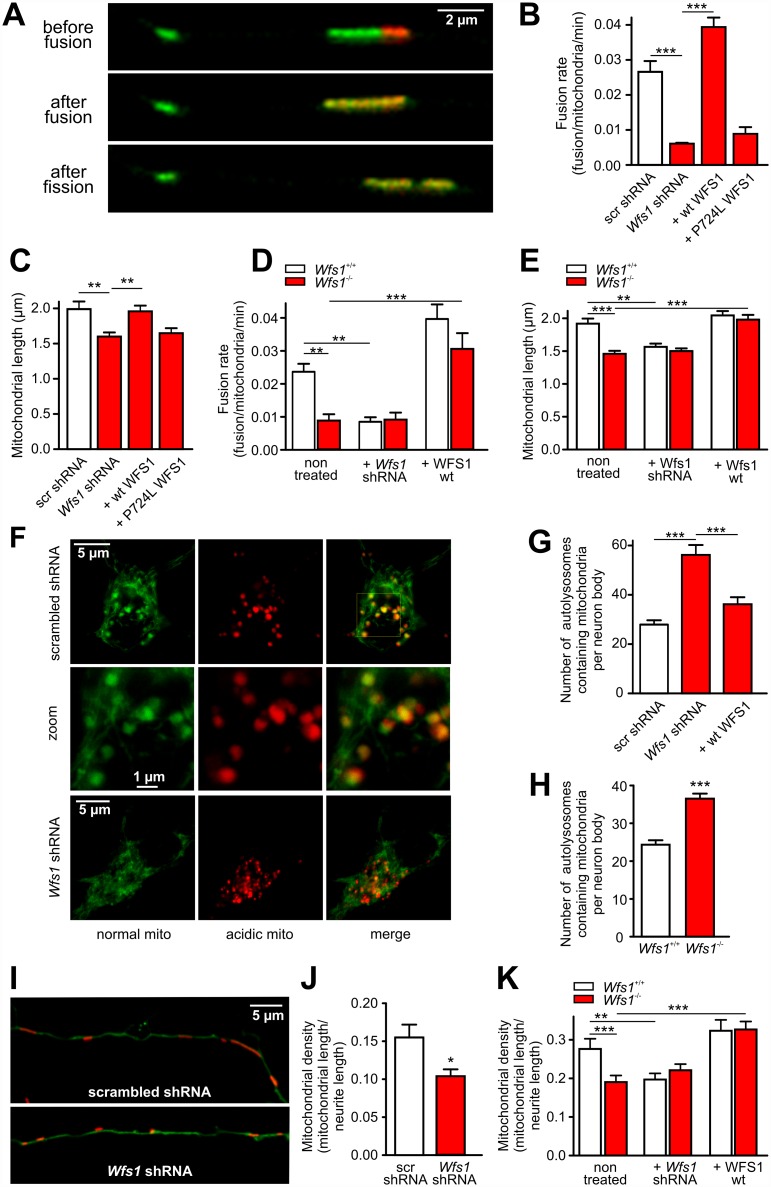
WFS1 deficiency impairs mitochondrial dynamics.(A) Primary cortical neurons were transfected with the photoconvertible mitochondrially targeted construct mito-Kikume-Green and scrambled shRNA or Wfs1 shRNA. Selected mitochondria were irradiated using a 405-nm laser line, thereby converting mito-Kikume-Green into mito-Kikume-Red. Fusion events between mito-Kikume-Green and photoactivated mito-Kikume-Red mitochondria are visible when mitochondria become yellow after mixing of the contents of the red and green mitochondria. (B–E) In primary cortical neurons, Wfs1 shRNA significantly decreases fusion rate (B) and mitochondrial length (C). These parameters are restored by overexpression of wild-type (wt) WFS1 but not by P724L WFS1, a mutant found in Wolfram syndrome. Similar changes are observed in cortical neurons isolated from Wfs1-/- mice. The lower fusion rate (D) and reduced mitochondrial length (E) in Wfs1-/- neurons is restored by wt WFS1 overexpression, but Wfs1 shRNA has no effect on these parameters. (F–H) Primary cortical neurons were transfected with mitochondrially targeted Keima (which changes its excitation spectrum under acidic conditions) and scrambled shRNA or Wfs1 shRNA (F). The number of autolysosomes containing mitochondria increases in Wfs1-silenced neurons (G) and in neurons isolated from Wfs1-/- mice (H). (I–K) Representative images of mitochondrial morphology and density in the axons of scrambled- and Wfs1-shRNA transfected neurons (I). The density of axonal mitochondria is reduced in Wfs1-silenced neurons (J) and in neurons isolated from Wfs1-/- mice (K). This parameter is restored by wt WFS1 overexpression, but Wfs1 shRNA has no effect. *p < 0.05, **p < 0.01, and ***p < 0.001 compared with respective control groups. Underlying data is shown in S1 Data.